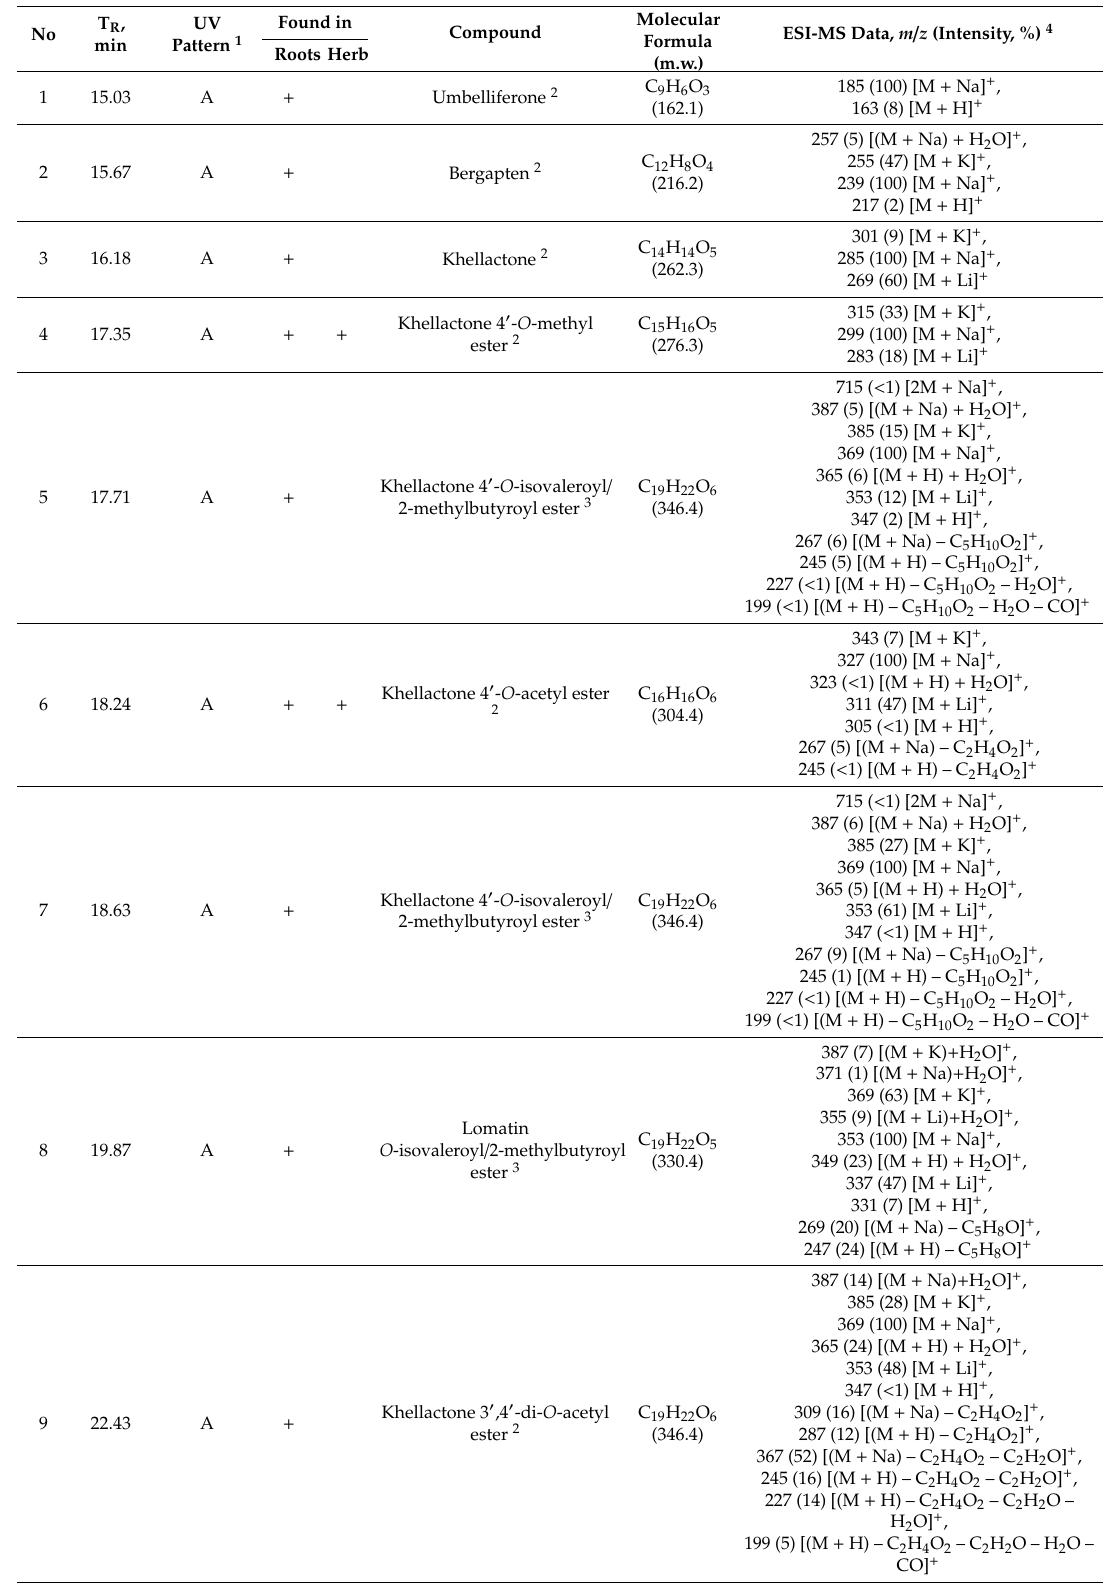
Table 2. Identified compounds in P. sibiricus root and herb